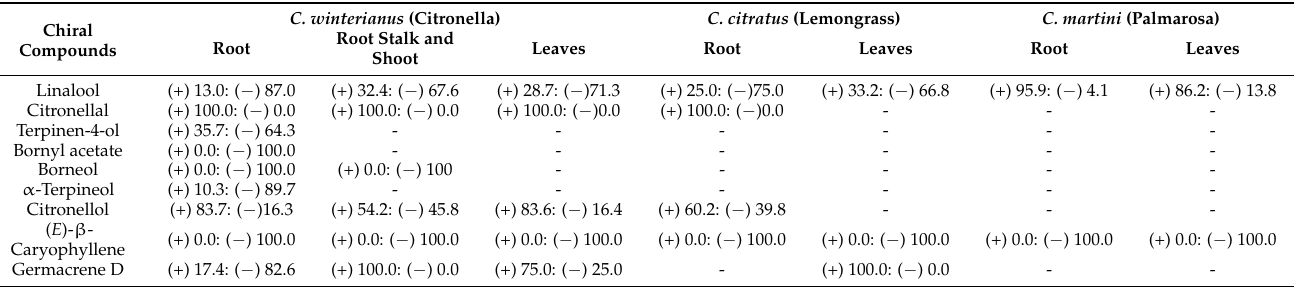
Table 5. Enantiomeric distributions of chiral terpenoids present in Cymbopogon